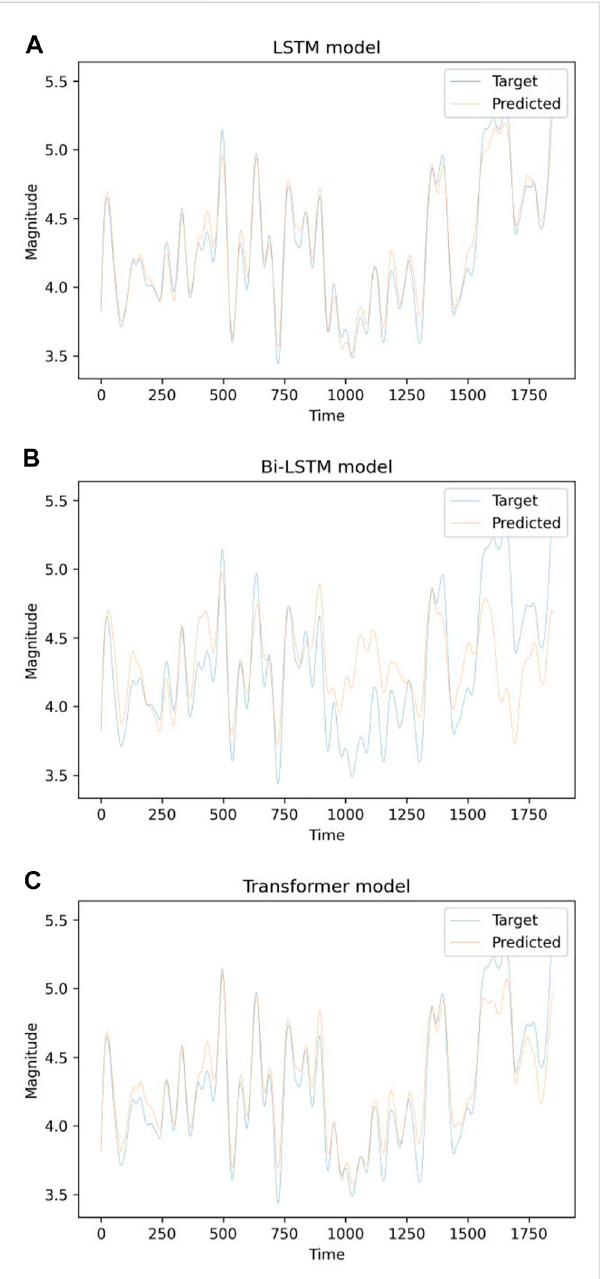
FIGURE 18 Plot of projected and actual magnitude as a function of time for the HKKH region earthquake catalogue using the (A) LSTM, (B) Bi- LSTM, and (C) transformer models.